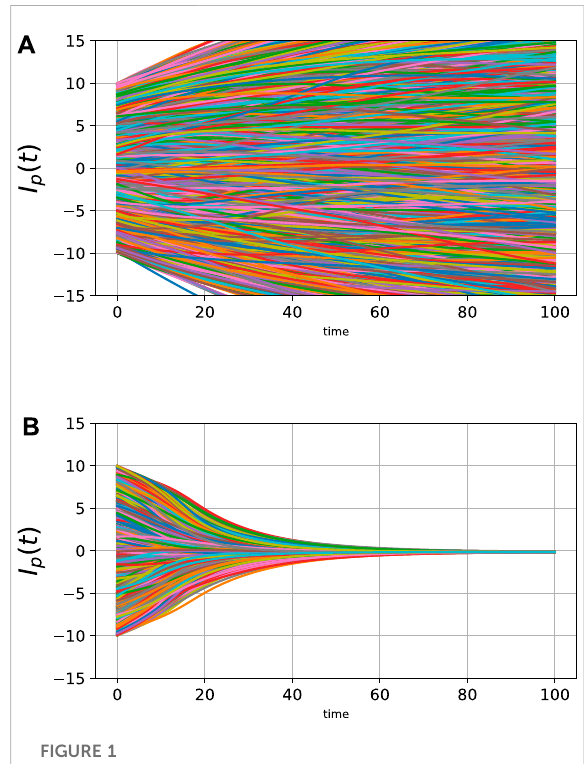
FIGURE 1 Two examples of changes in an opinion distribution: (A) opinions diverge and a consensus is not built, and (B) opinions converge and a consensus is built. Each panel shows the changes in the values of all individuals ’ opinions in a particular simulation result using the L r type (random graph) of interaction structure.Thehorizontalaxisindicatesthesimulationtime,andthe vertical axis indicates the opinion value. Here, we set the parameters as (| N |, α , β , δ , γ , κ ) = (1,600, 1, 10, 0.002, 0.1, 10), with θ = 0.3 in (A) and θ = 0.8 in (B)